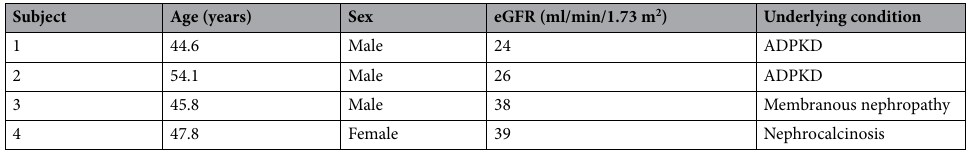
Table 3. Characteristics of CKD patients. ADPKD autosomal dominant polycystic kidney disease, eGFR estimated glomerular filtration rate according to CKD-EPI.